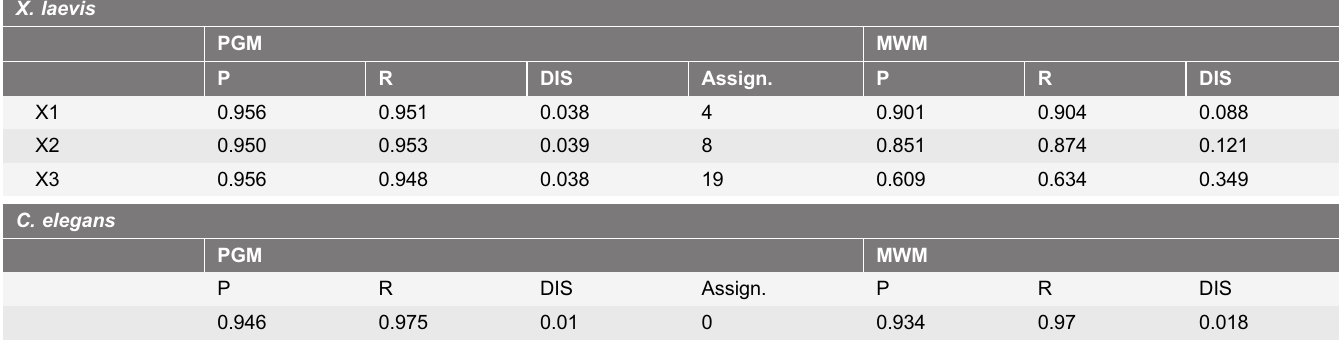
Table 1. Comparison of probabilistic matching (PGM) and maximum weighted matching (MWM).